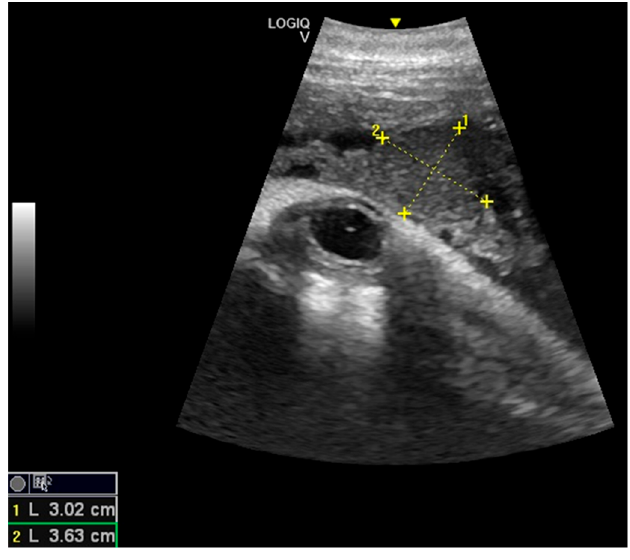
Figure 1. Corpus luteum (CL) with measurements.